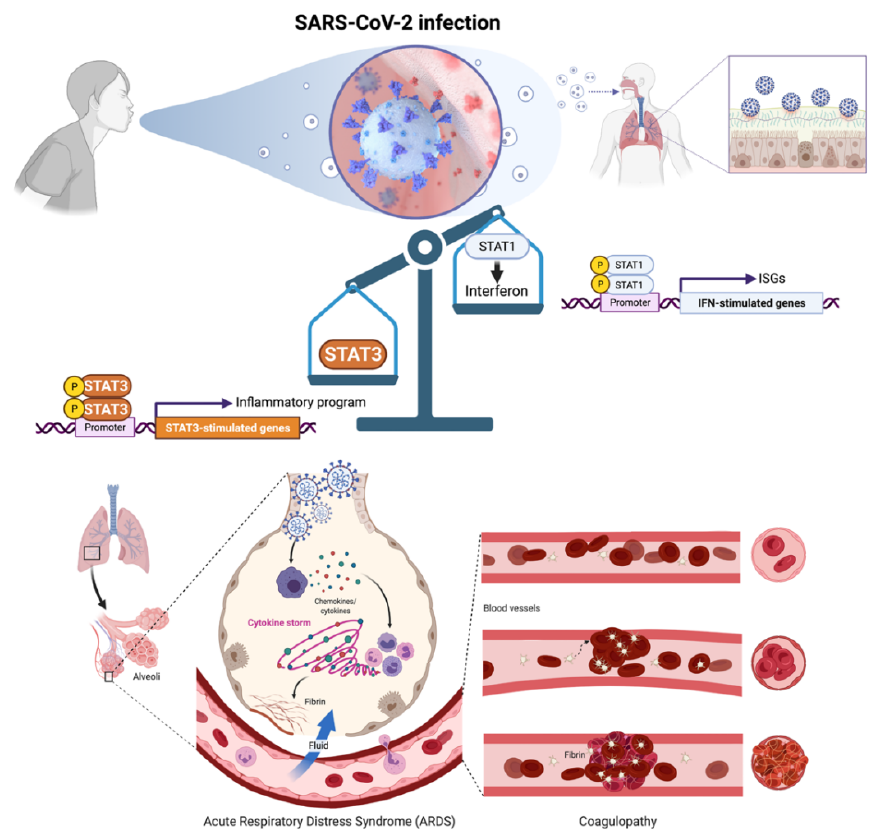
Figure 1. SARS-CoV-2 infection-driven STAT1-to-STAT3 transcriptional shifting is central to COVID-19 pathophysiology. SARS-CoV-2-mediated inhibition of STAT1/IFN-I-stimulated genes (ISGs) and the subsequent shift to a hyperactive, STAT3 dominant proinflammatory and immune response signaling may drive the key clinical features of severe COVID-19 including acute respira- tory distress syndrome (ARDS) and coagulopathy/thrombosis events. Prevention of the excessive, compensatory activation of STAT3 that occurs once STAT1 is compromised and symptoms arise after SARS-CoV-2 infection, is a therapeutic avenue that might impede the combinatorial activation of both ARDS-driving inflammatory cytokines/chemokines and plasminogen activator inhibitor-1 (PAI-1)-related coagulopathy/thrombosis events in severe COVID-19 cases. Created with Biorender.com.